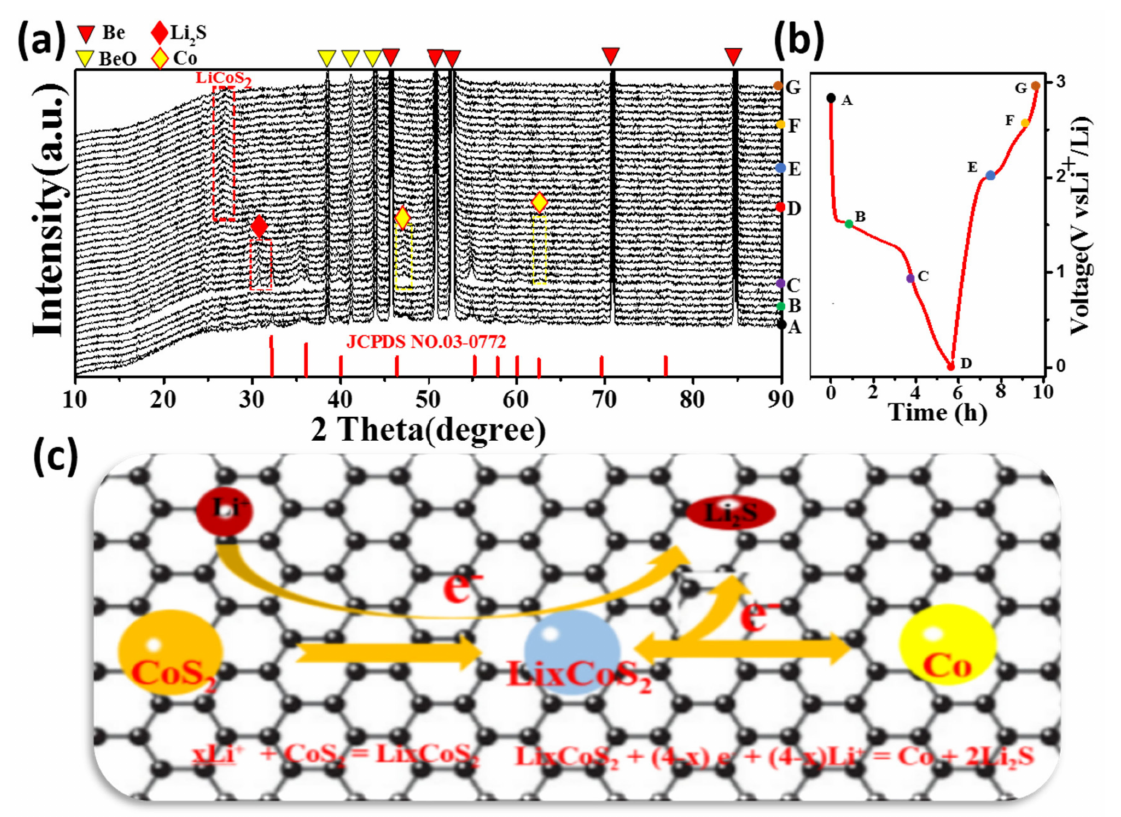
Figure 6. ( a ) In situ XRD investigation of CSG nanometers Cut-off: 0.001-3.0 V versus Li/Li + . Current density: 0.2 C. (A,B,C,D,E,F,G correspond to XRD at each voltage value); ( b ) The corresponding XRD pattern during the first cycle. ( c ) Schematic diagram of the mechanism of CSG storing lithium.